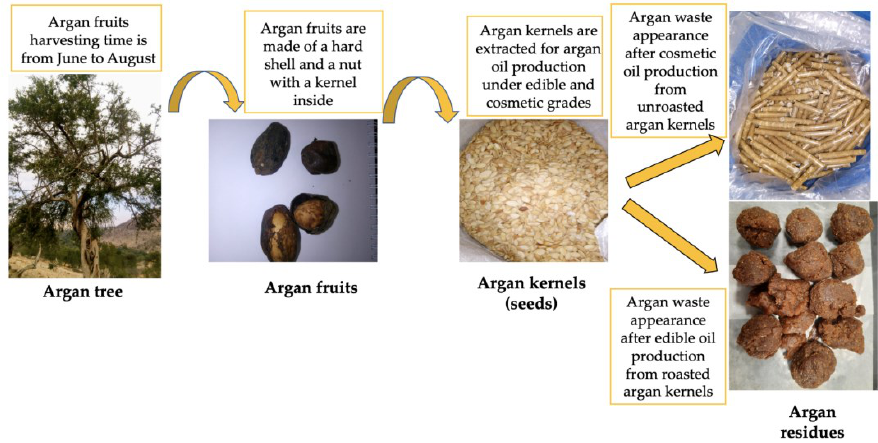
Figure 1. Argan fruits are harvested in a period from June to August. The hard pulp is removed, and the kernels extracted from the nut are pressed for the oil extraction. The argan residue was used as waste biomass for biopolymer